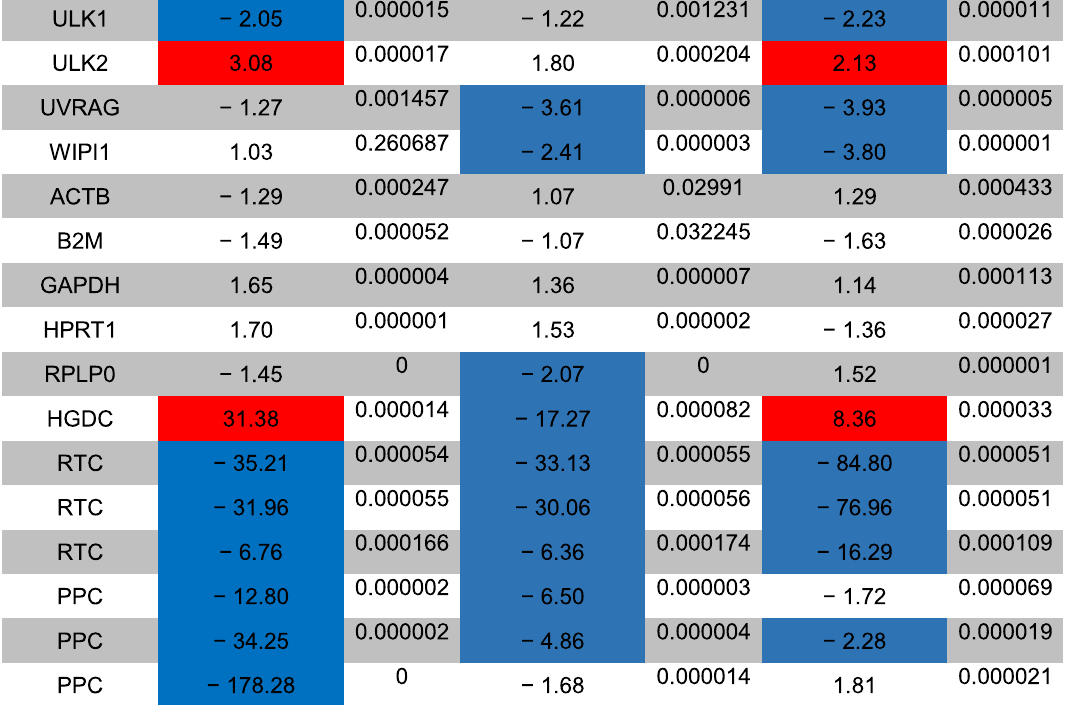
to proteasomal degradation 40 . Therefore, it seems that the 8-min incubation of CSCs may disrupt the autophagy